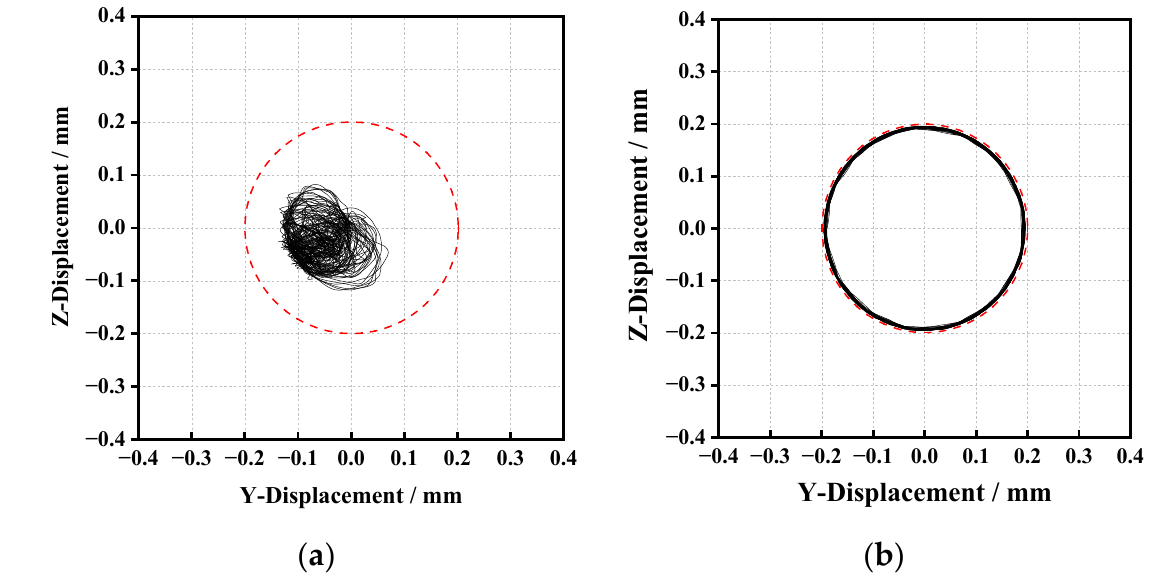
Figure 6. Simulation results of cage whirl orbit: ( a ) F r = 200 N, n i = 10,000 r/min; ( b ) F r = 200 N, n i = 30,000 r/min.